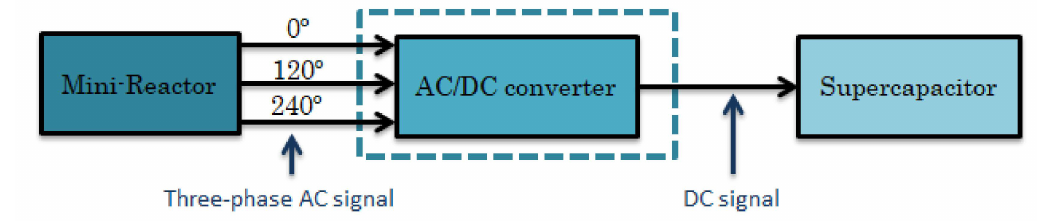
Figure 20. AC complete system block